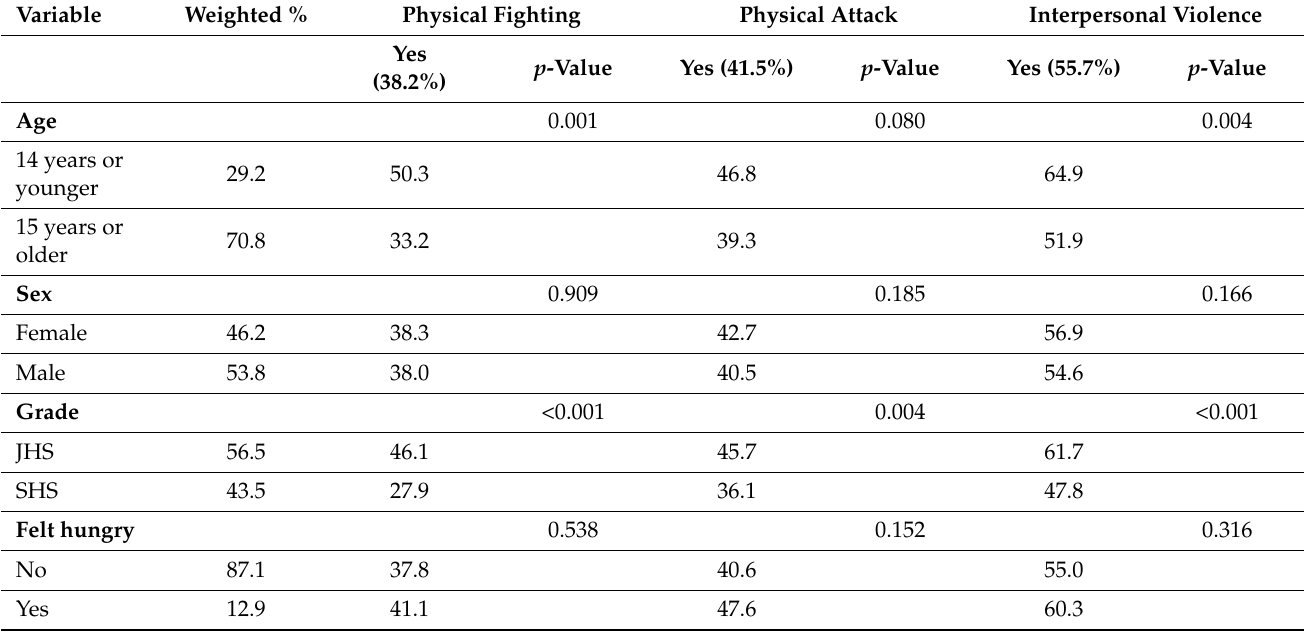
Table 1. Bivariable analysis of proportions of physical fighting, physical attack, and interpersonal violence among in-school adolescents in Ghana (N =